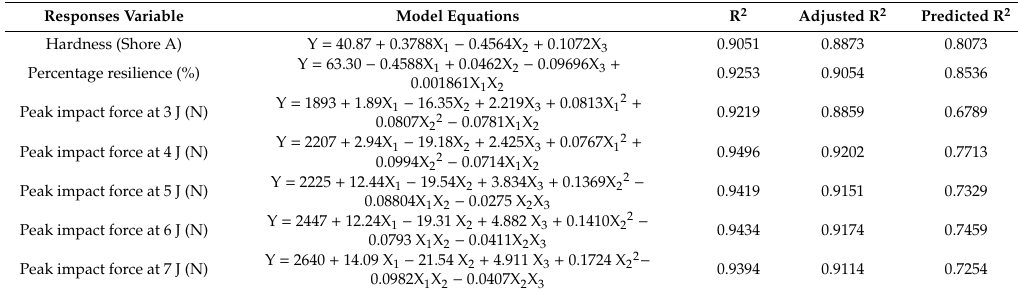
Table 3. DoE regressed equations for di ff erent testing responses and analysis regression